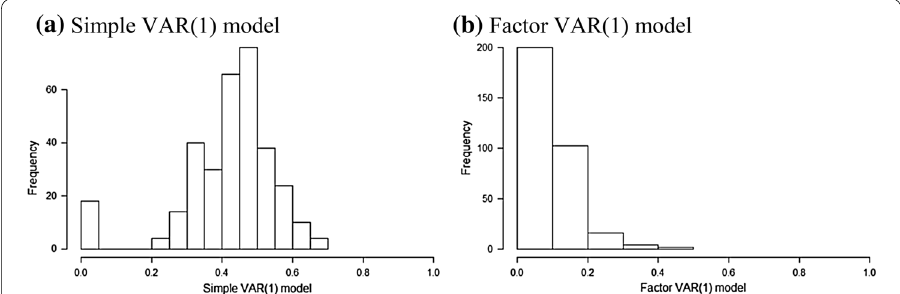
Fig. 1 Comparison of absolute residual correlations, with and without factors. Notes The histograms show the distribution of the absolute pairwise correlations between the residuals of the simple VAR(1) model and our factor VAR(1) model evaluated by